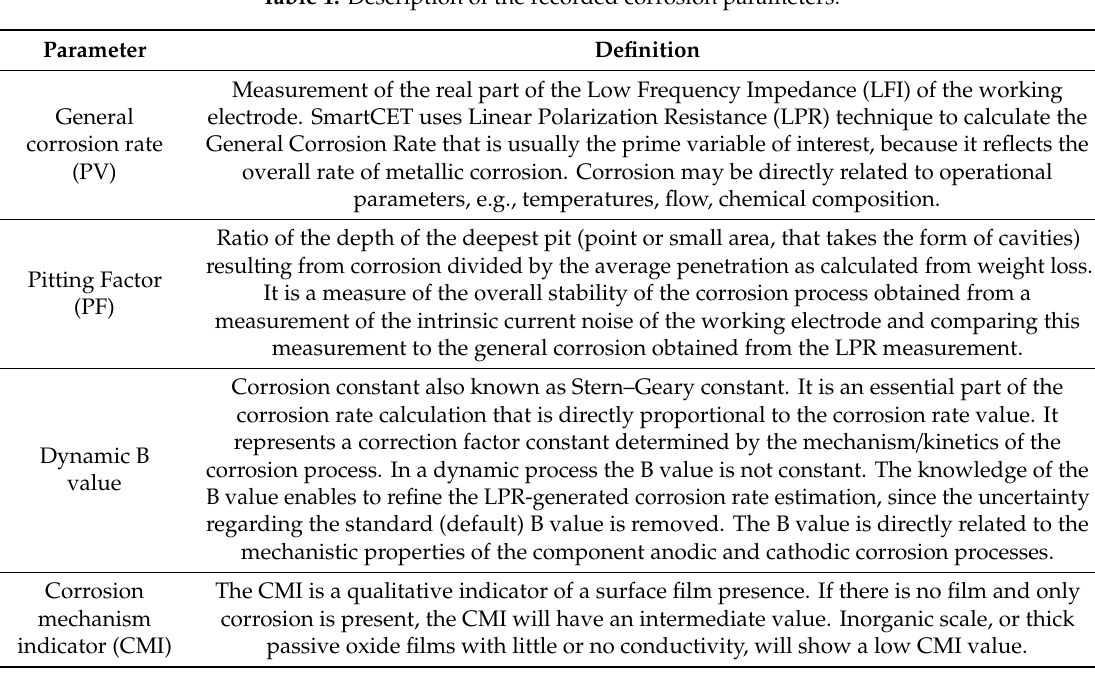
Table 1. Description of the recorded corrosion